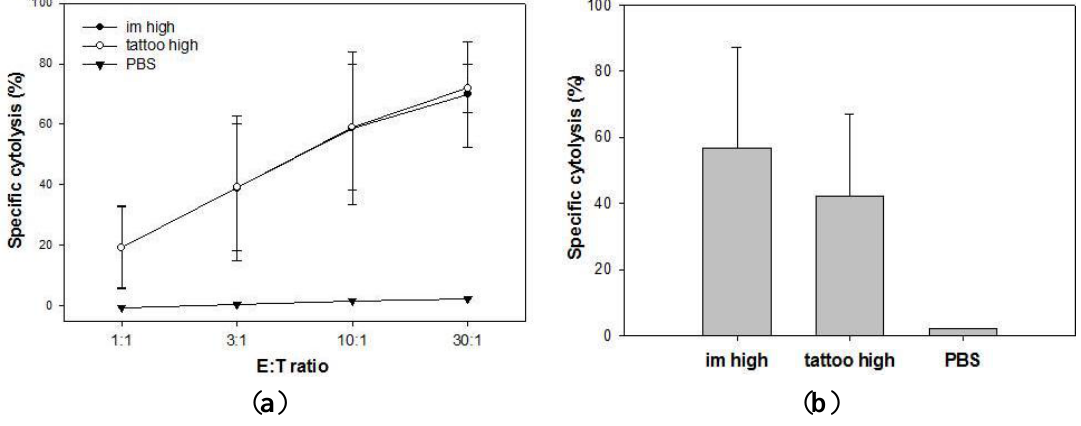
Figure 4. SFVeE6,7 tattooing induces long-lasting memory T cells. Mice that survived tumor challenge as depicted in Figure 3 were sacrificed on day 90 after tumor inoculation. Isolated spleen and inguinal lymph node cells were in vitro restimulated for seven days. Activity of restimulated spleen ( a ) and lymph node ( b ) cells were analyzed in regular and micro CTL assay, respectively. E:T ratio—effector:target